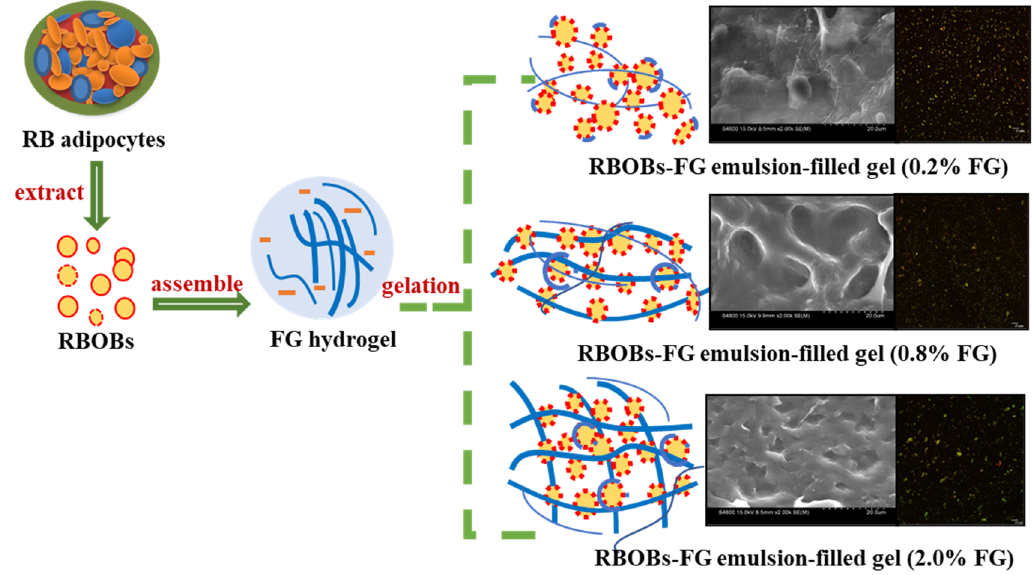
Figure 9. Schematic diagram of the RBOB-FG emulsion-filled gels.